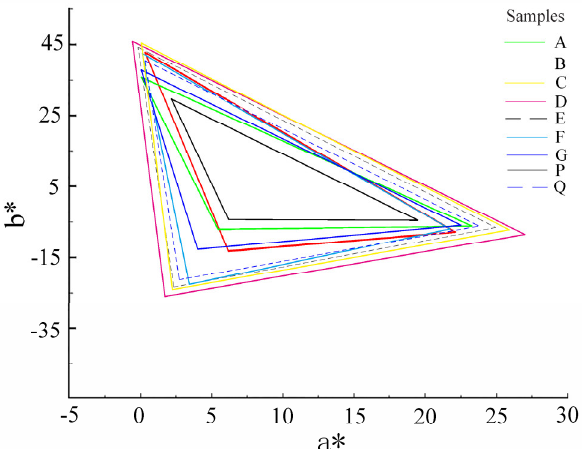
Figure 10. Color gamut of different inkjet printing samples.